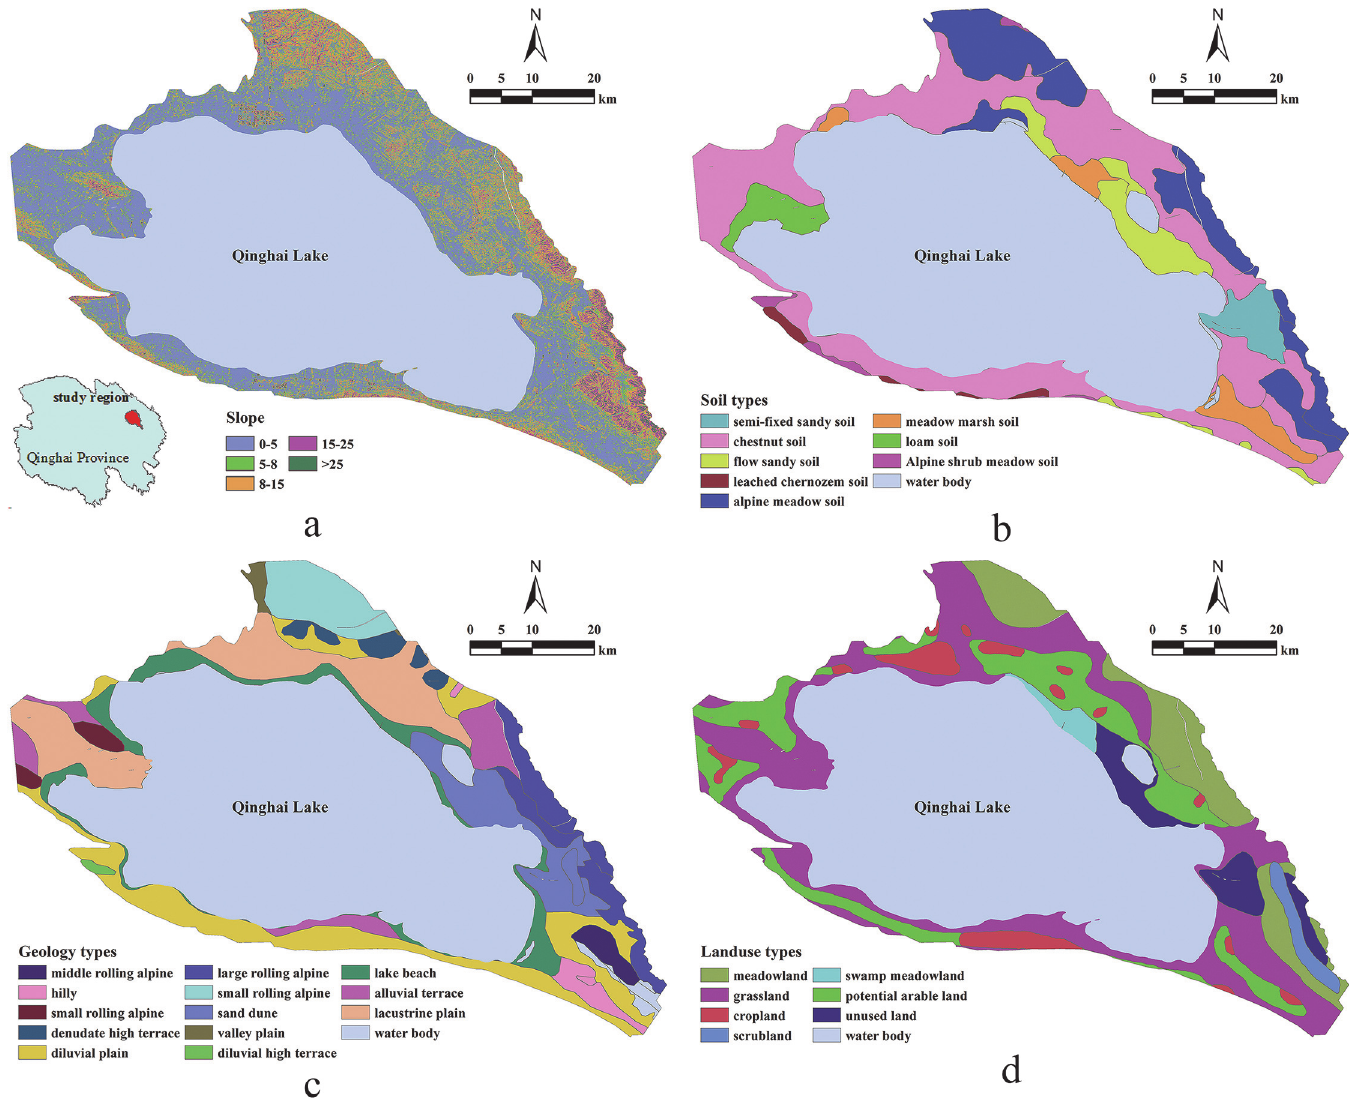
Fig 2. Environmental information of the study area. Types of (a) slope, (b) soil, (c) geology, and (d) land use.